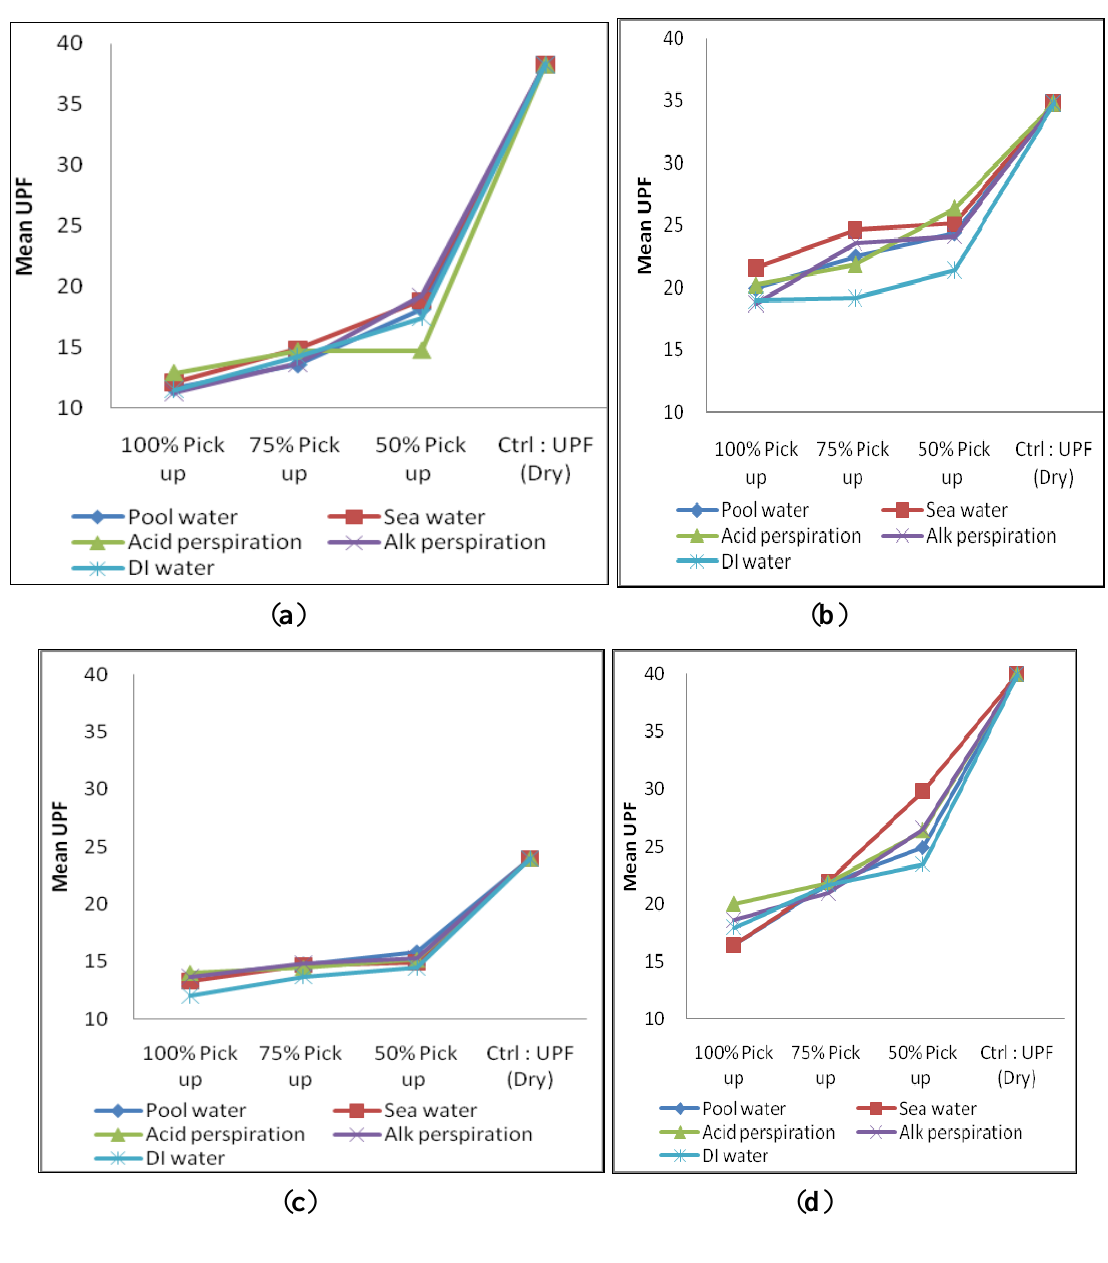
Figure 5. UPF of Group III samples: ( a ) CM; ( b ) CM _ CH; ( c ) CM _ MCG; ( d ) CM _ F